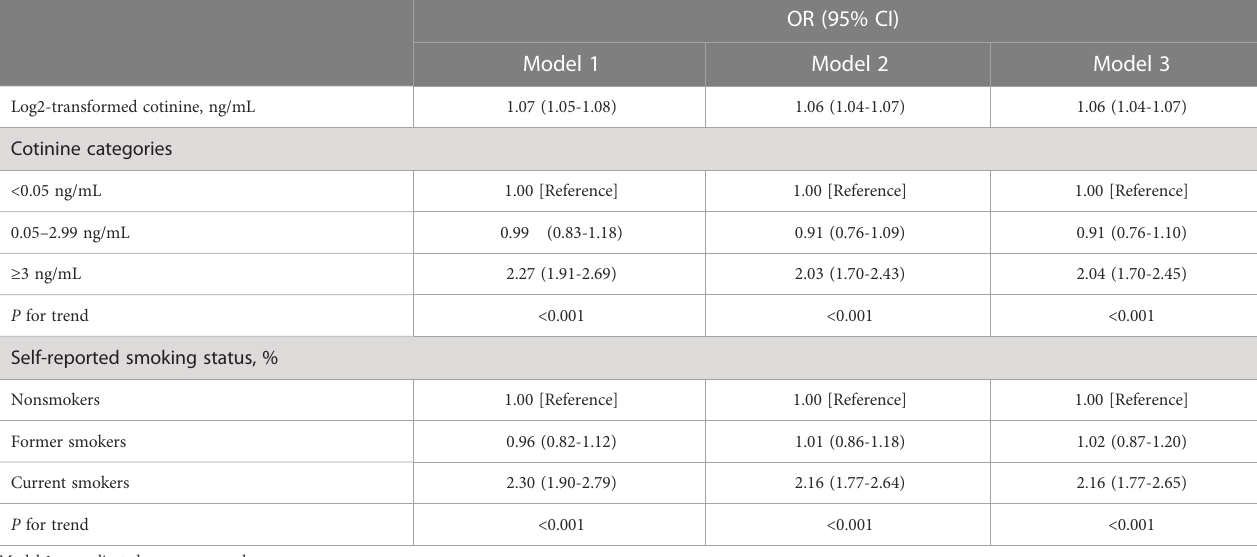
TABLE 3 Association of smoking status, serum cotinine level and the prevalence of